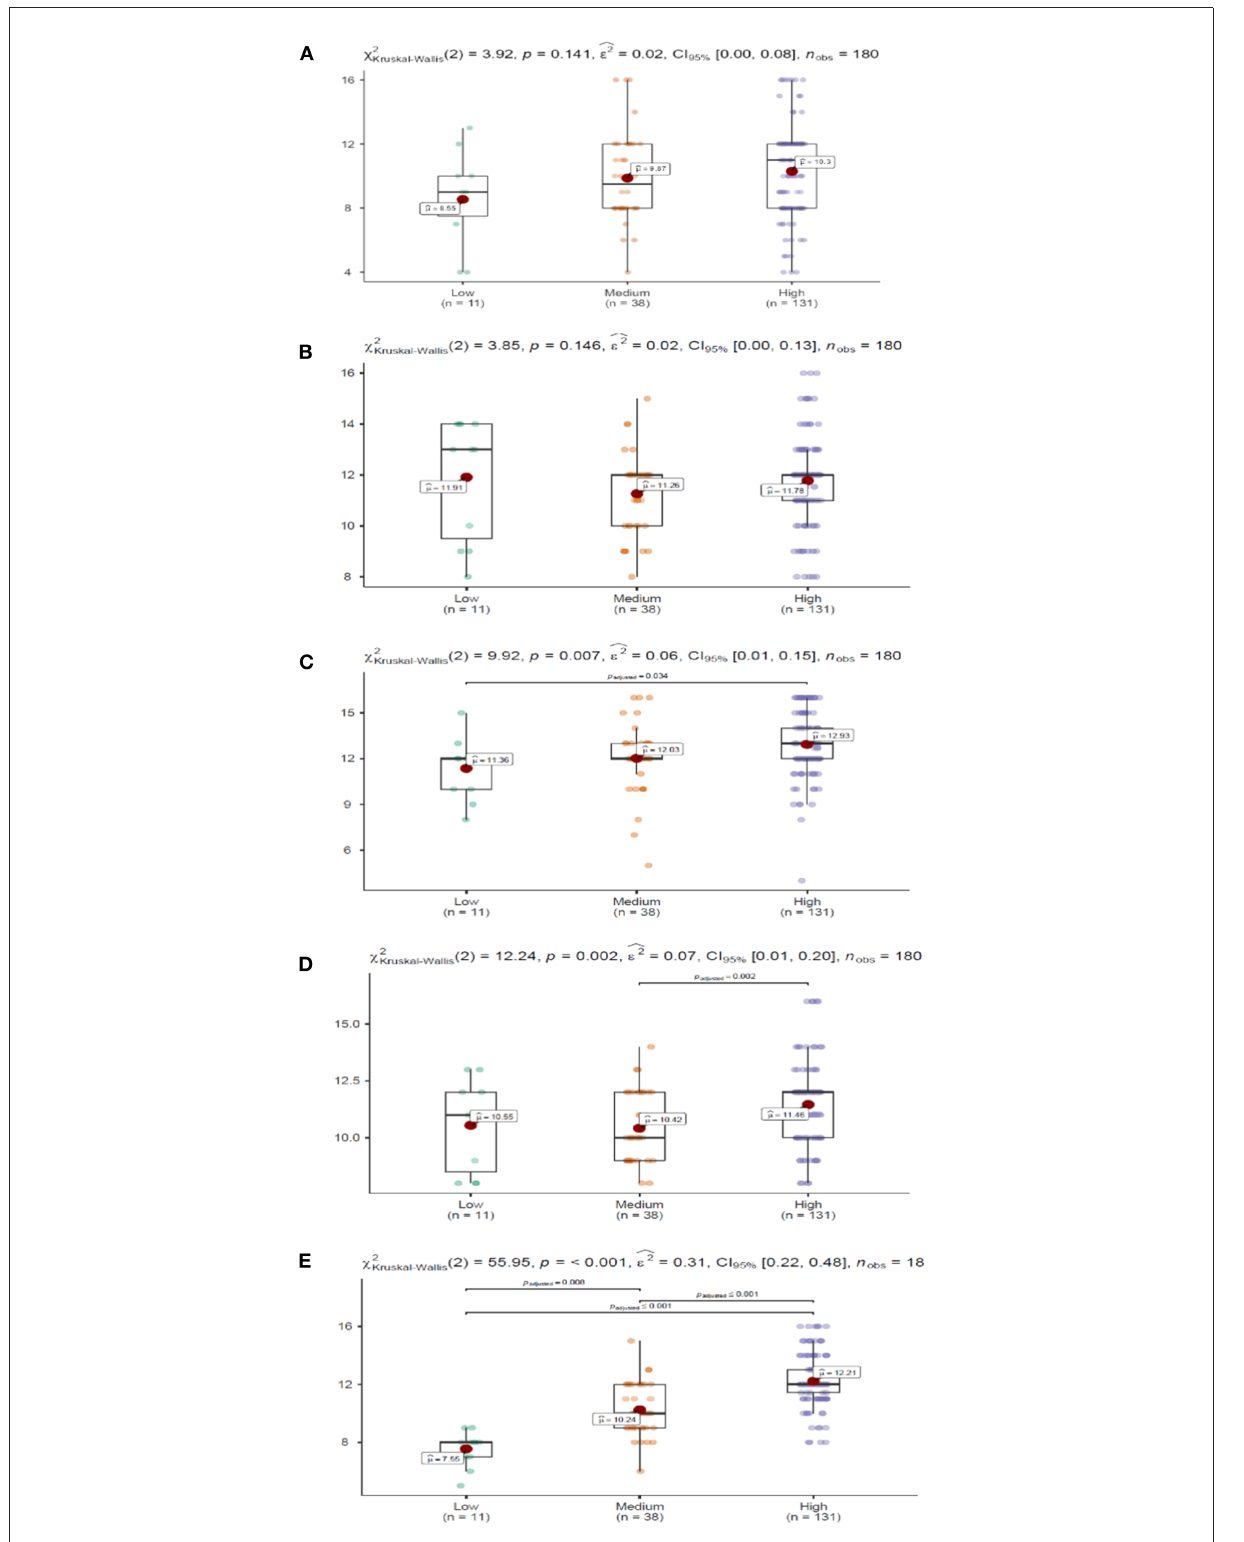
FIGURE1 Emotional intelligence by self-esteem level. Dimensions: (A) Intrapersonal, (B) Interpersonal, (C) Stress Management, (D) Adaptability, and (E) Mood. Nonparametric pairwise multiple comparisons in independent groups using Dunn’s test. Adjustment method (p-value):